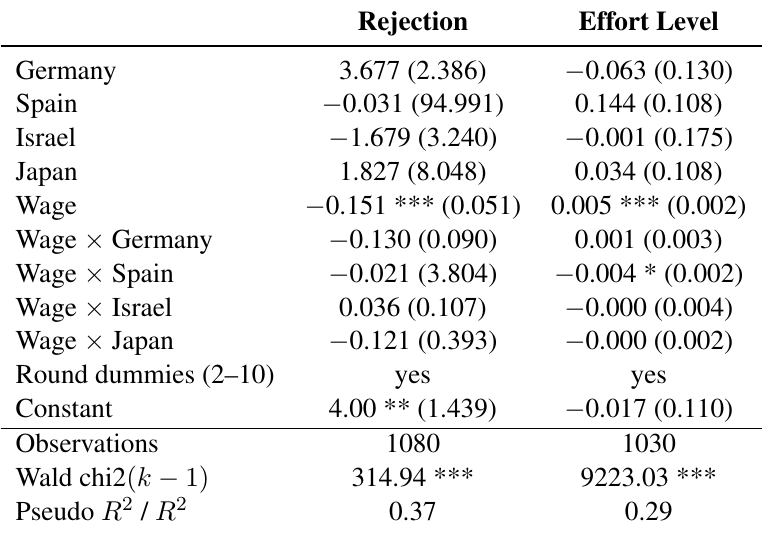
Table 3. Hurdle model estimation for the random-matching